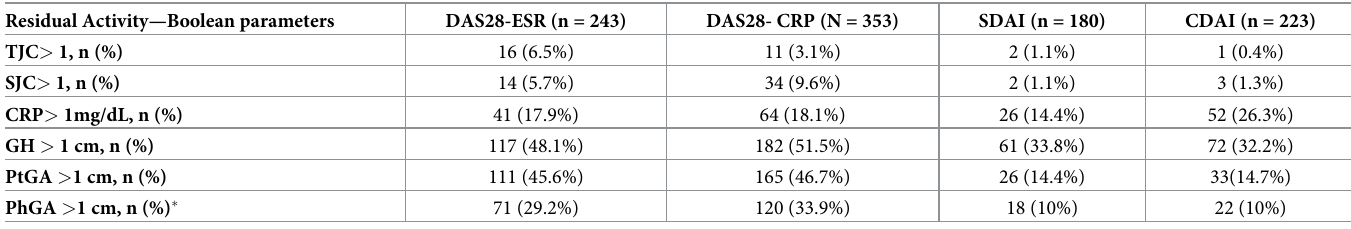
Table 5. Residual activity according to various remission activity states. Residual Activity—Boolean